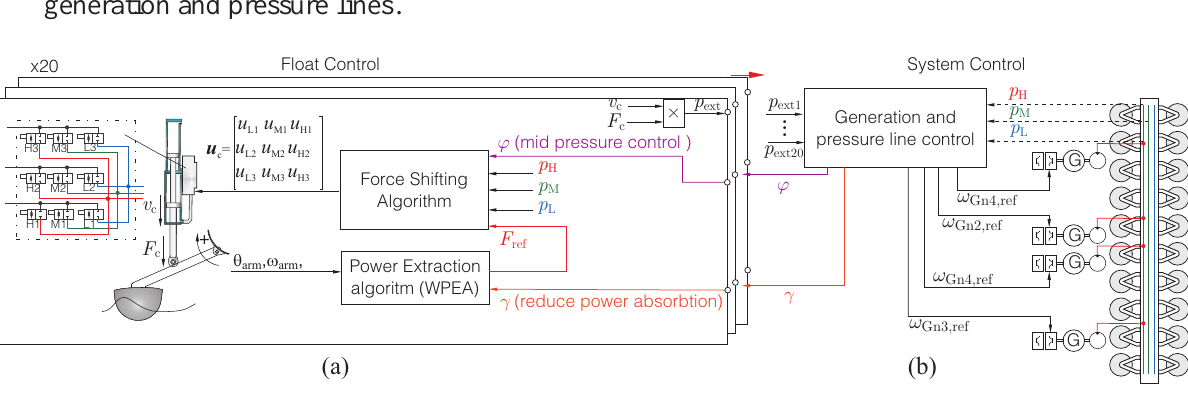
Figure 20. ( a ) float control (20 parallel system), handling the manifold control to track the generated force reference to extract wave power; and ( b ) system control for controlling generation and pressure